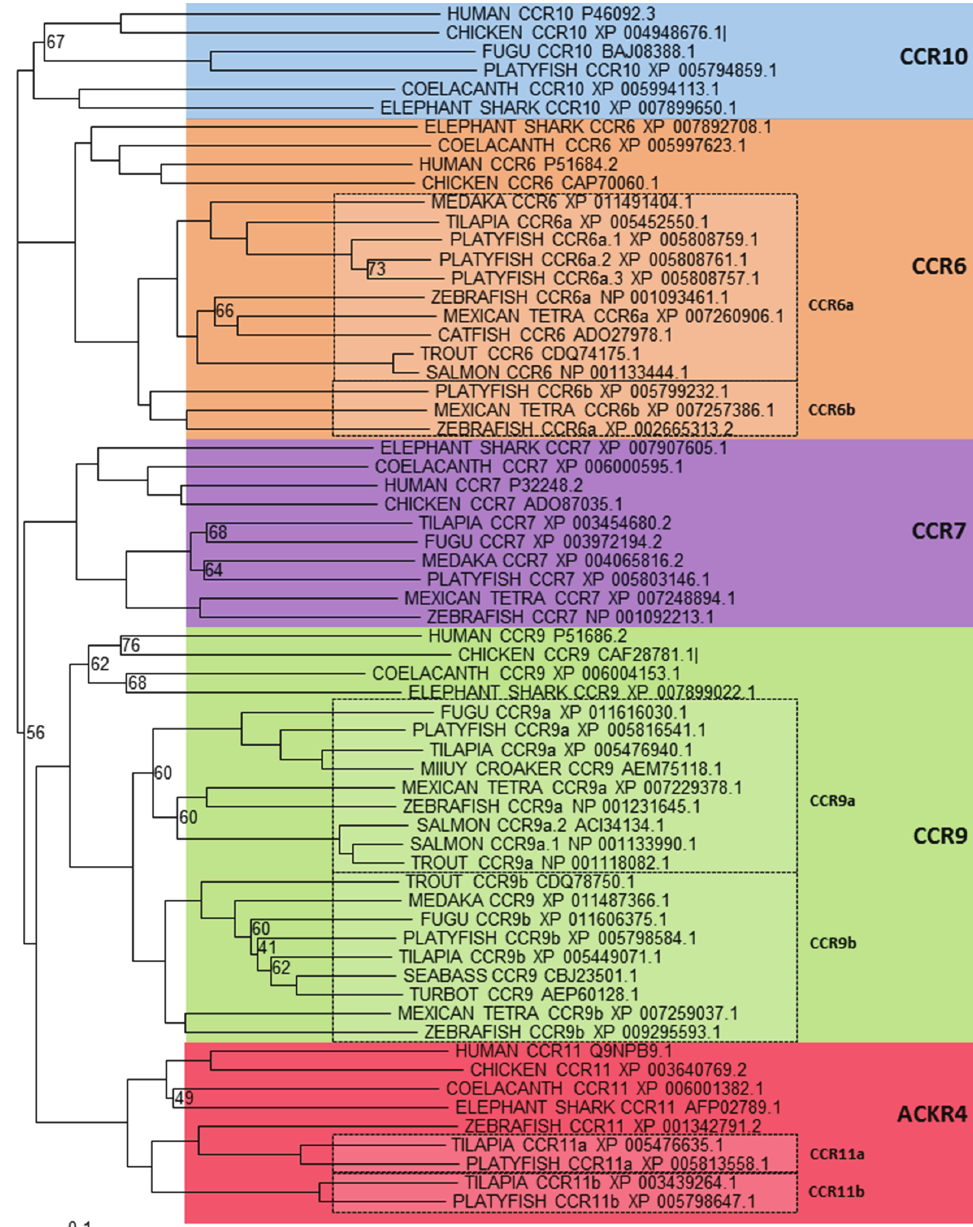
Figure 1. Phylogenetic analysis of human CCR6, 7, 8, 9, 10 and ACKR4 (CCR11) amino acid sequences with identified teleost, reptile, bird, amphibian and cartilaginous fish sequences. Accession numbers of each sequence are included in the figure. Sequences were found by using the FASTA [108] and BLAST [109] suite of programs to search the non-redundant protein sequence database at NCBI. Phylogenetic relationships were constructed from ClustalX v1.81 [110] generated alignments of amino acid sequences using the neighbor-joining method [111], with values <75% shown. The tree was drawn using TreeView v1.6.1 [112] and bootstrapped 1000 times [113]. A different colour is used to indicate the clear clustering of sequences into each receptor group. Boxed regions indicate where there has been an expansion of a particular receptor, within